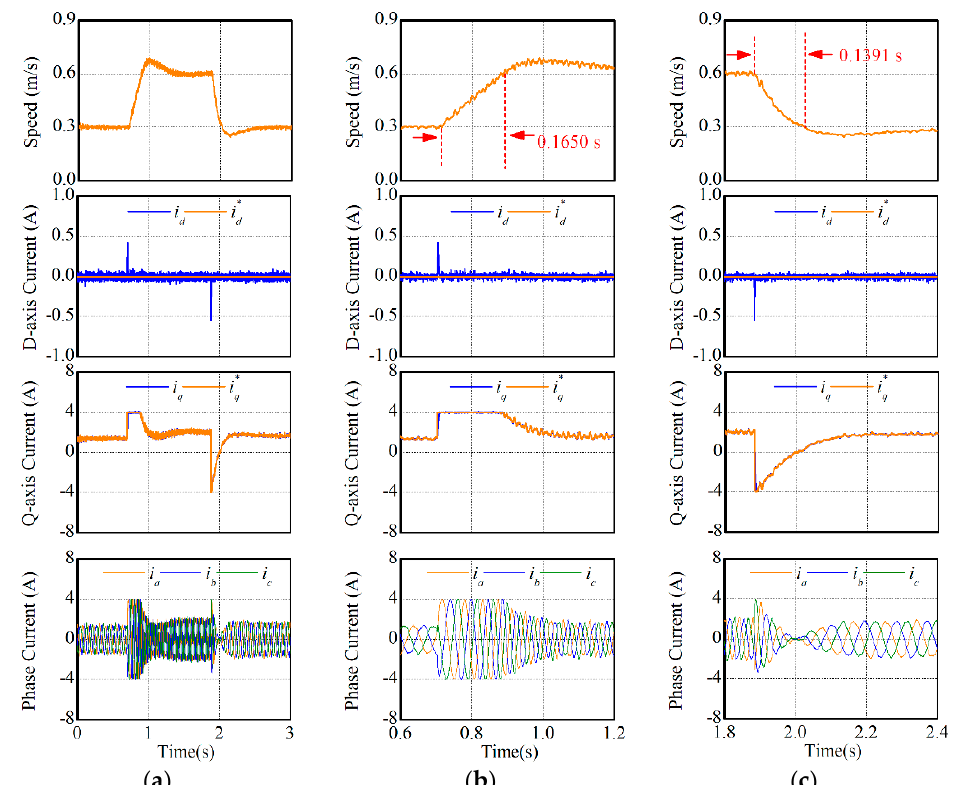
Figure 10. Speed response performances of MPCC-II. ( a ) t = 0–3 s, ( b ) t = 0.6–1.2 s, and ( c ) t = 1.8–2.4 s.